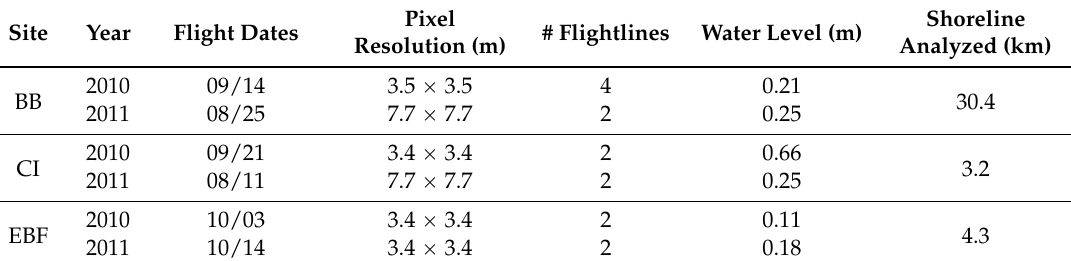
Table 1. Site information regarding data acquisition for each study site (East Bird’s Foot—EBF, Barataria Bay—BB, and Chandeleur Islands—CI) such as time and date of acquisition, pixel resolution, number of flightlines, and tidal stage. Water levels are calculated based on the mean lower low water (MLLW) height